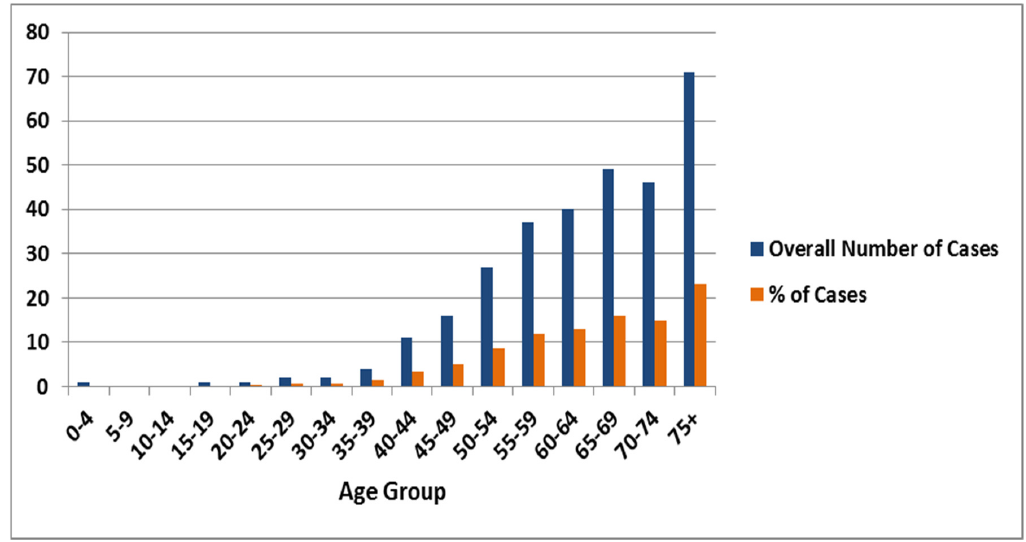
Figure 1. Graphical representation of overall number and percentage of lung cancer cases in males during 2006 to 2016.